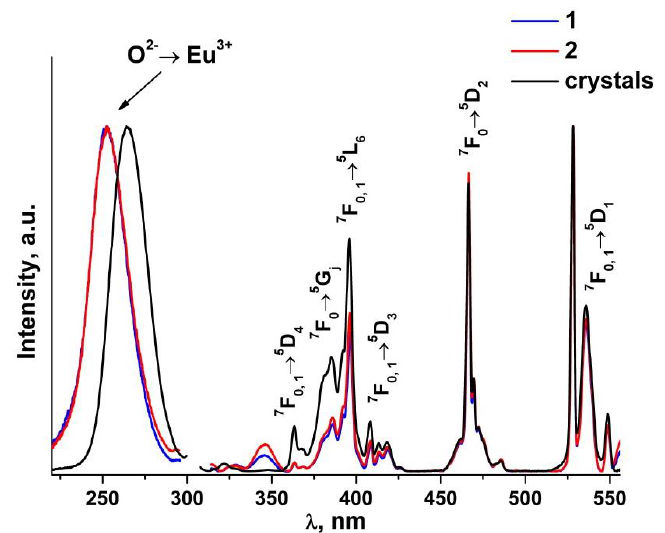
Figure 10. Luminescence excitation spectra of (ZrO 2 ) 0.879 (Y 2 O 3 ) 0.12 (Eu 2 O 3 ) 0.001 single crystal and (ZrO 2 ) 0.909 (Y 2 O 3 ) 0.09 (Eu 2 O 3 ) 0.001 ceramic solid solutions synthesized using different methods from crushed single crystals: (1) uniaxial compaction; (2) slip casting. λ em = 606 nm, Т = 300 K. The excitation spectra of the (ZrO 2 ) 0.909 (Y 2 O 3 ) 0.09 (Eu 2 O 3 ) 0.001 ceramics (Figure 10) con- tain a sufficiently wide symmetrical band in the 220 to 290 nm region peaking at ~253 nm, which according to earlier data [41] originates from the O 2- → Eu 3+ charge transfer transi- tion. For the (ZrO 2 ) 0.879 (Y 2 O 3 ) 0.12 (Eu 2 O 3 ) 0.001 single crystal, this band is at a greater wave- length ( ~ 265 nm). Along with the O 2- → Eu 3+ charge transfer band, the luminescence exci- tation